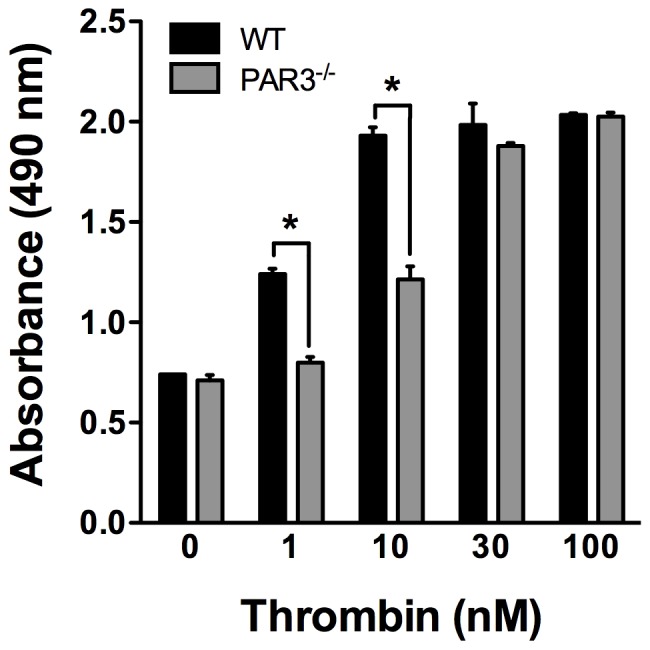
RhoA activity measured by G-LISA Kit in mouse platelets.The level of activated RhoA-GTP is measured by absorbance at 490 nm in response to increasing concentrations of thrombin (1–100 nM). The results are from three independent experiments (* p<0.05, ns: not significant).